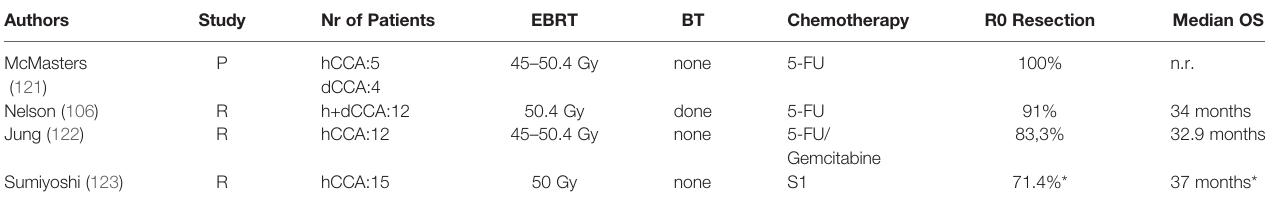
TABLE 3 | Neoadjuvant chemoradiation of advanced cholangiocarcinoma.